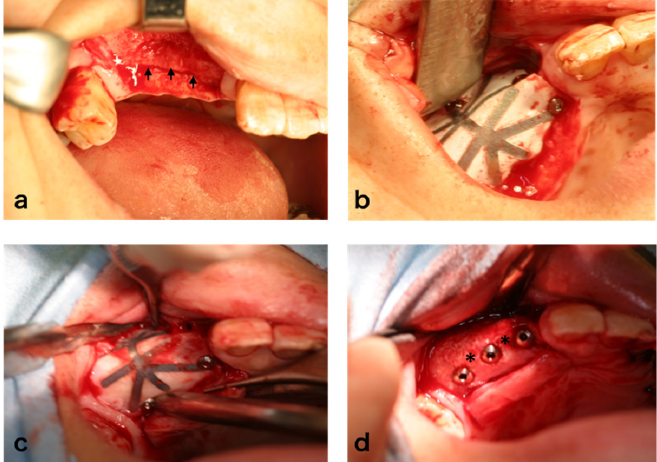
Figure 4. Alveolar ridge augmentation: ( a ) arrows show atrophied alveolar bone, ( b ) guided bone regeneration with ePTFE membrane, ( c ) 6 months after surgery, and ( d ) dental implant insertion (asterisks indicate regenerated bone).